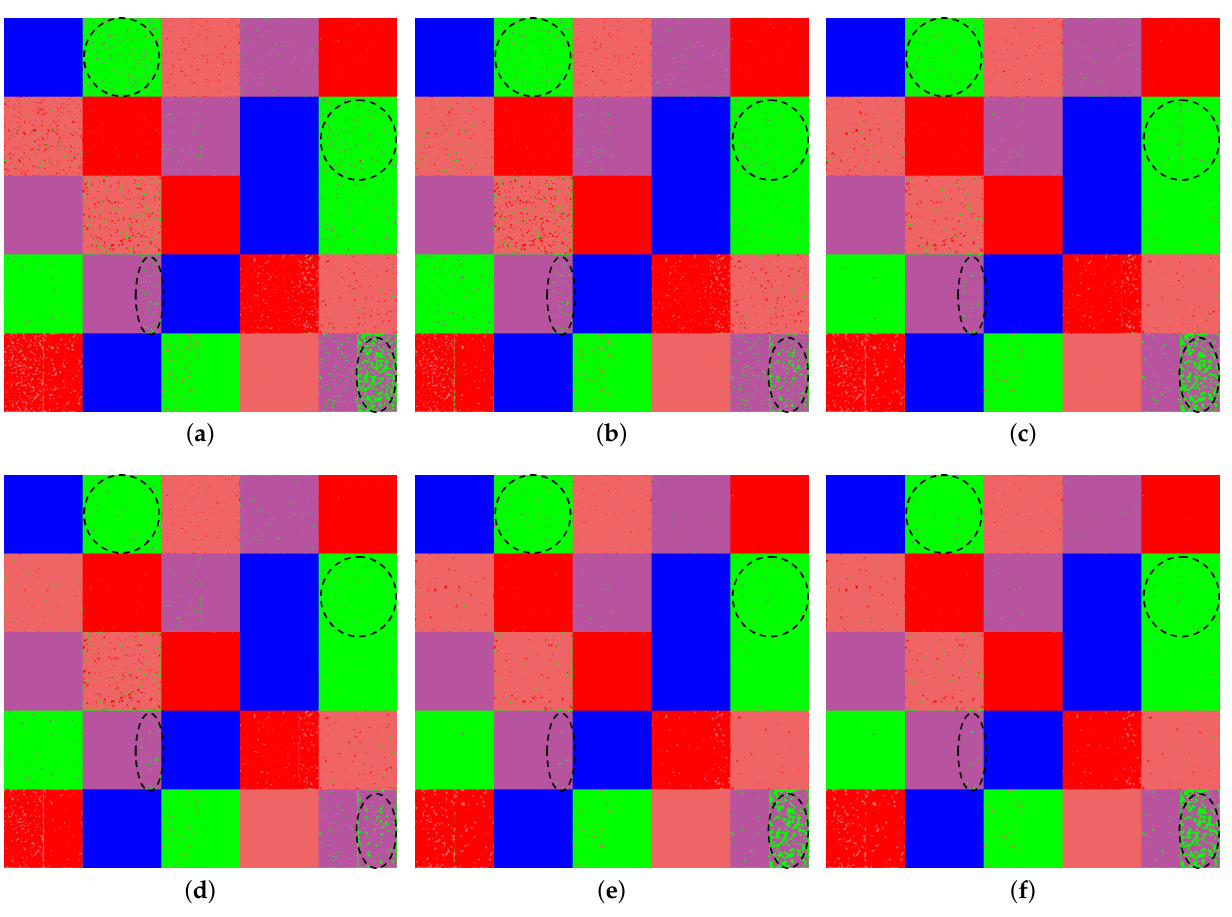
Figure 7. Classification maps of six algorithms on the simulated PolSAR dataset. ( a ) WMM-MRF.